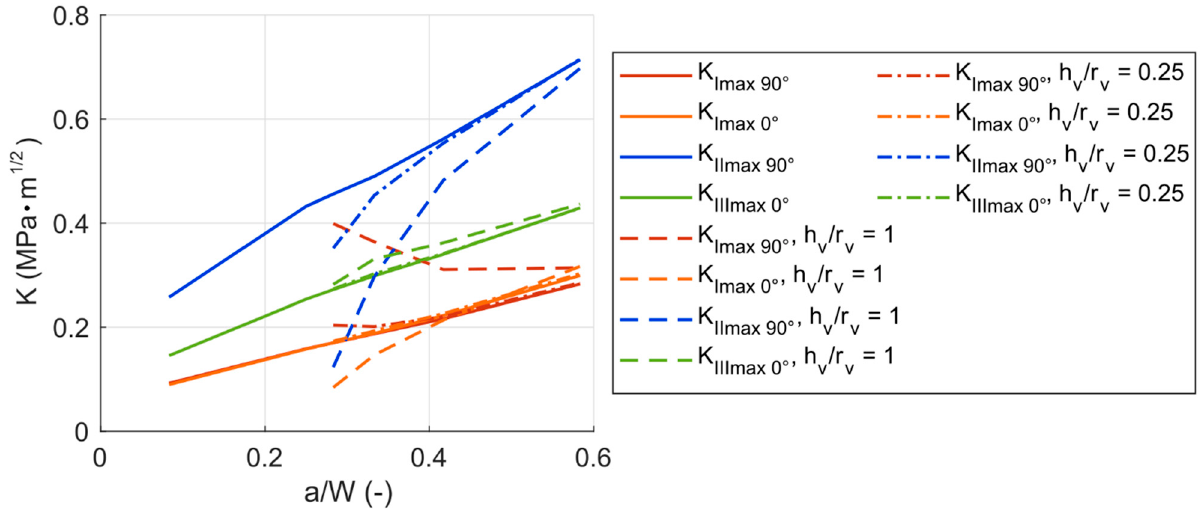
Figure 15. K max for different crack tip positions depending on the normalized crack length—comparison of the model with Table 0. mm, h v /r v = 0.25 or 1).